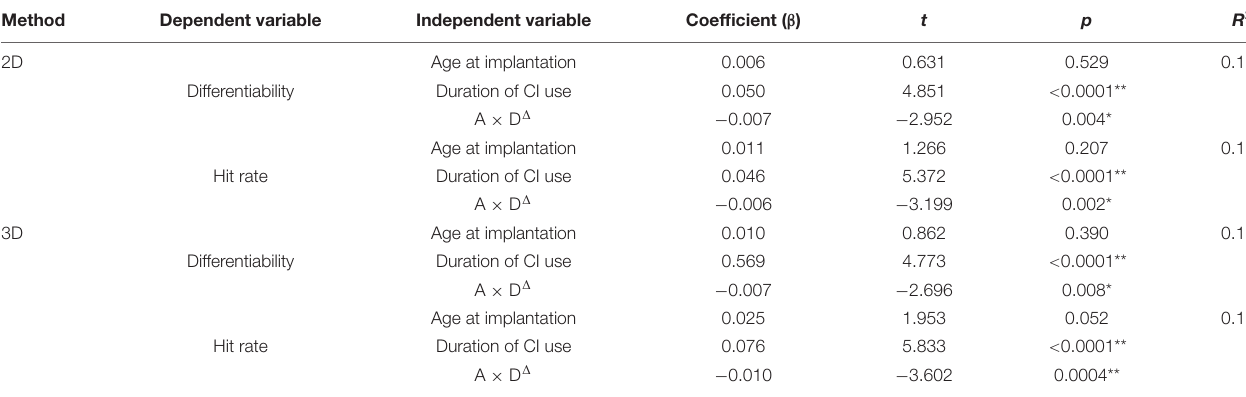
TABLE 2 | Results of the GLM